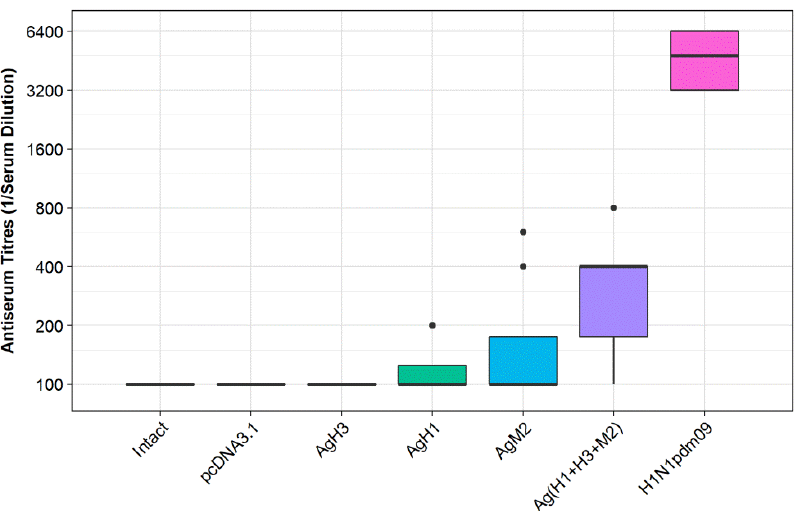
Figure 5. Serum antibody titers observed in BALB / c mice immunized with DNA vaccine constructs encoding the antigens. AgH1, mice immunized with DNA-plasmid p-AgH1; AgH3, mice immunized with DNA-plasmid p-AgH3; AgM2, mice immunized with DNA-plasmid p-AgM2; Ag(H1 + H3 + M2), mice immunized with a mix of DNA-plasmids p-AgH1 + p-AgH3 + p-AgM2; pcDNA3.1, mice immunized with vector plasmid (negative control); intact, nonimmunized mice (negative control); and H1N1pdm09, mice immunized with A / California / 07 / 2009 (H1N1pdm09) virus strain (positive control).